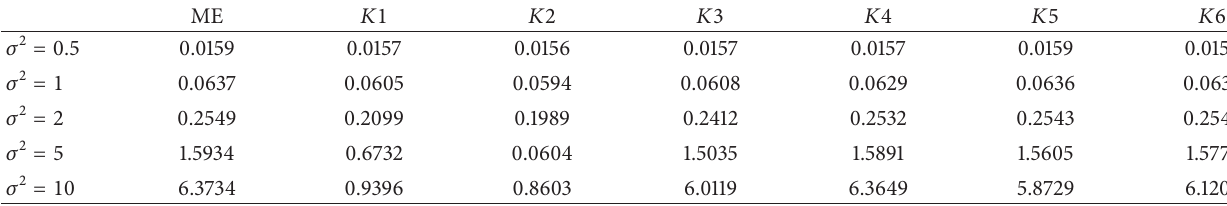
Table 1: Estimated MSE with 𝑛 = 50 , 𝑝 = 4 , and 𝛾 = 0.75 .